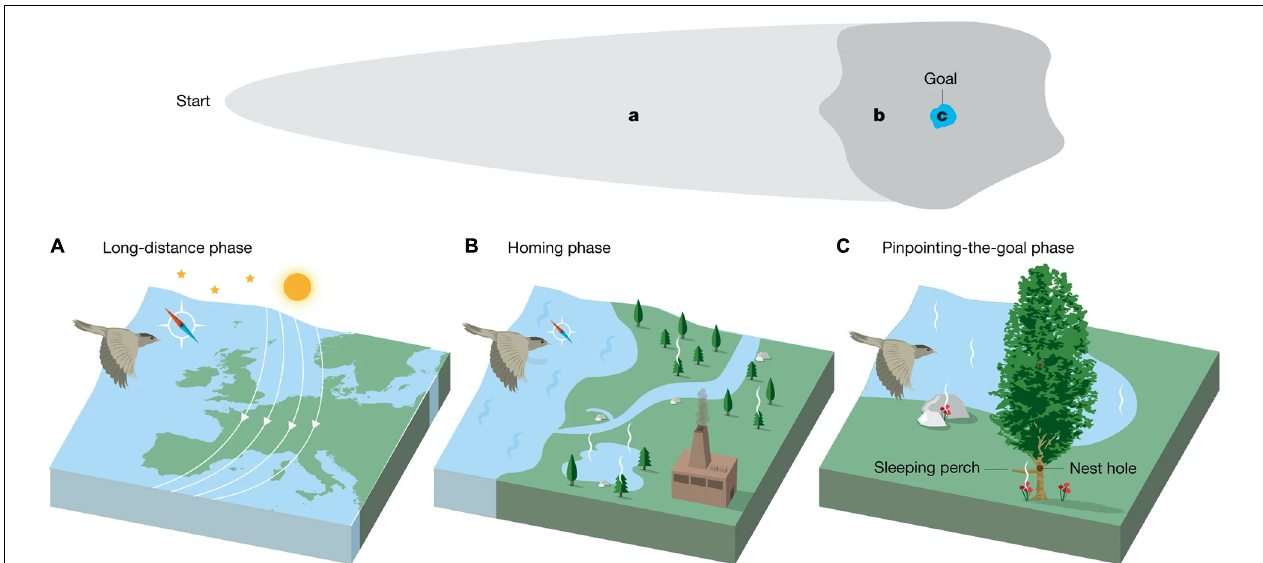
FIGURE 2 | Illustrated phases of long-distance navigation. (A) During the long-distance phase, individuals rely on celestial and magnetic cues as well as on large landmarks such as mountains, lakes, and coastlines. (B) During the homing phase, gradients, landmarks, and compasses are important. (C) During the pinpointing-the-goal phase, residential cues including beacons and the goal itself are valuable. Figure from Mouritsen (2018) with permission.